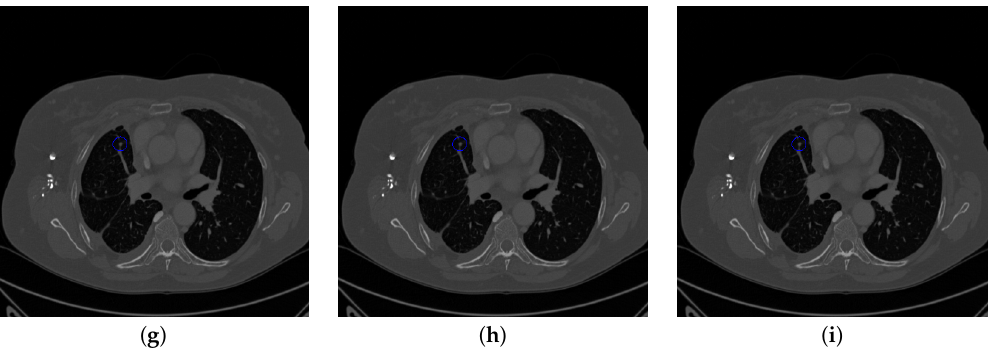
Figure 18. The result of detecting pulmonary nodules by different methods on another example image in LUNA16 dataset. Red circle represents the ground truth region of nodules, blue circles represent the correct estimation of pulmonary nodules, green circles represent the over-detected nodules, while yellow circles denote the nodules being omitted. ( a – i ) are: ground truth nodule in the given chest CT image, nodule detected by 3D-FCN, MR-CNN, 3D-UNET, PRN-HSN, DCNN, CLAHE-SVM, MASK-RCNN and our proposed method.